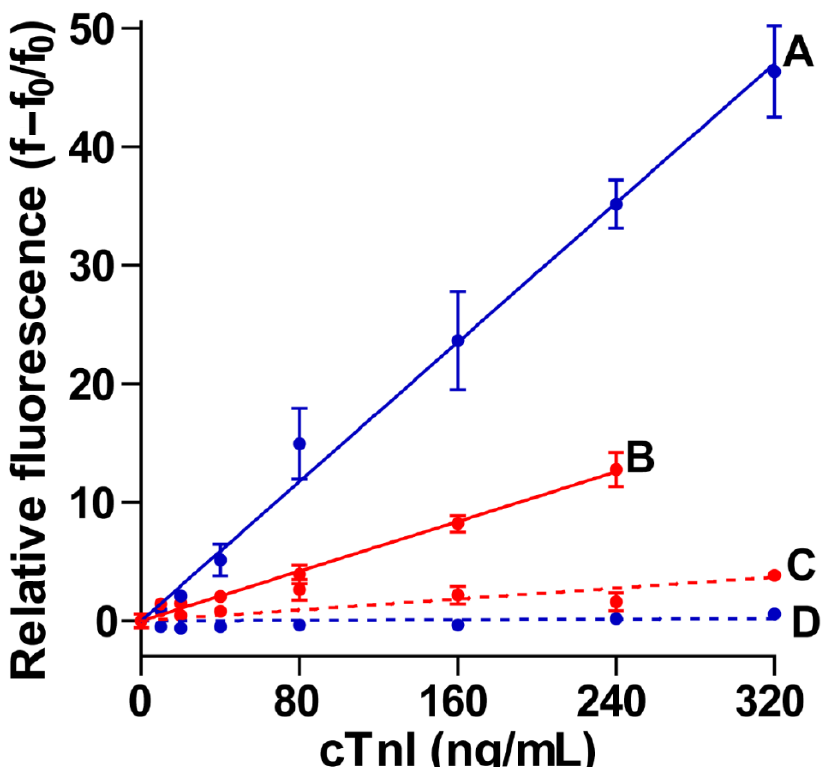
Figure 6. Comparison of the standardized assay (cTnI in BSA/human serum) with their reference assays. The relative emission at different levels of cTnI is plotted to a wide range of cTnI levels for (A) standardized immunoassay with cTnI-human serum and (B) standardized immunoassay with cTnI–BSA/PBS. C and D (dotted pattern plots) correspond to the reference assay for B and A, respectively. The reference assay indicates the standardized assay done in the absence of Ab 1 (microplate wells coated with 2% BSA instead of capturing antibodies were used as assay platform). Error bars represent the standard deviation of two independent triplicates. (Two-way ANOVA test showed that there is statistically insignificant difference ( p < 0.05) between the two independent assays for each of serum and PBS (for A, p = 0.533; for B, p = 0.795), and the change in the relative fluorescence for each assay is significantly dependent (for A, p < 0.001; for B, p < 0.001) on the concentration of cTnI in solution).